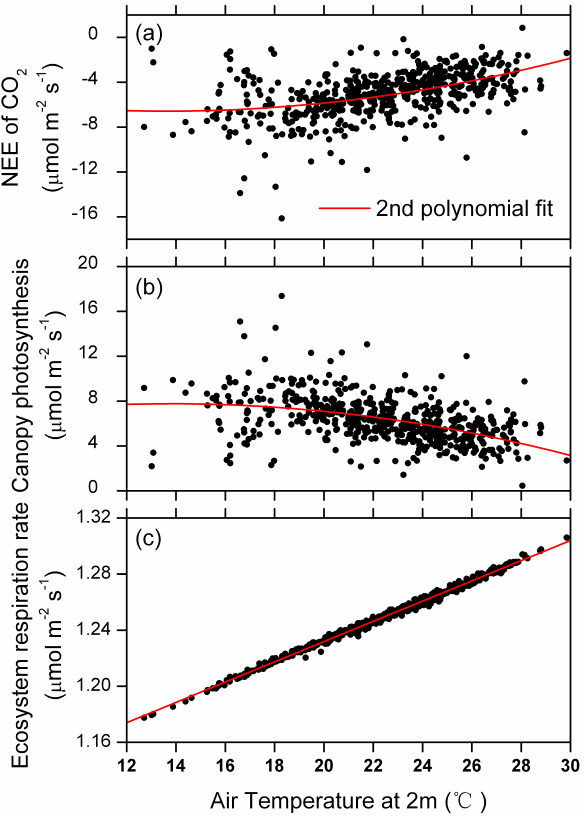
Fig. 9. Relationships between NEE of CO 2 (a) , canopy photo- synthesis (b) , ecosystem respiration rate (c) , and air temperature for 2nd polynomial fits ( n = 540, (a) r 2 = 0 . 22, (b) r 2 = 0 . 22, (c) r 2 = 0 . 99, p < 0 . 01).